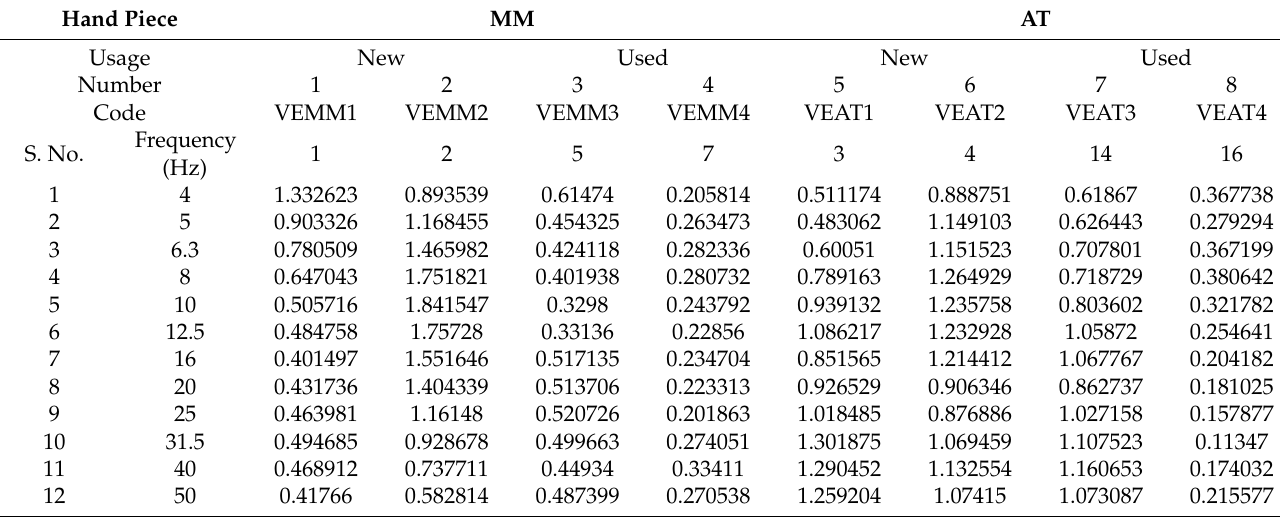
Table 9. 1/3rd-octave band average vibration transmissions